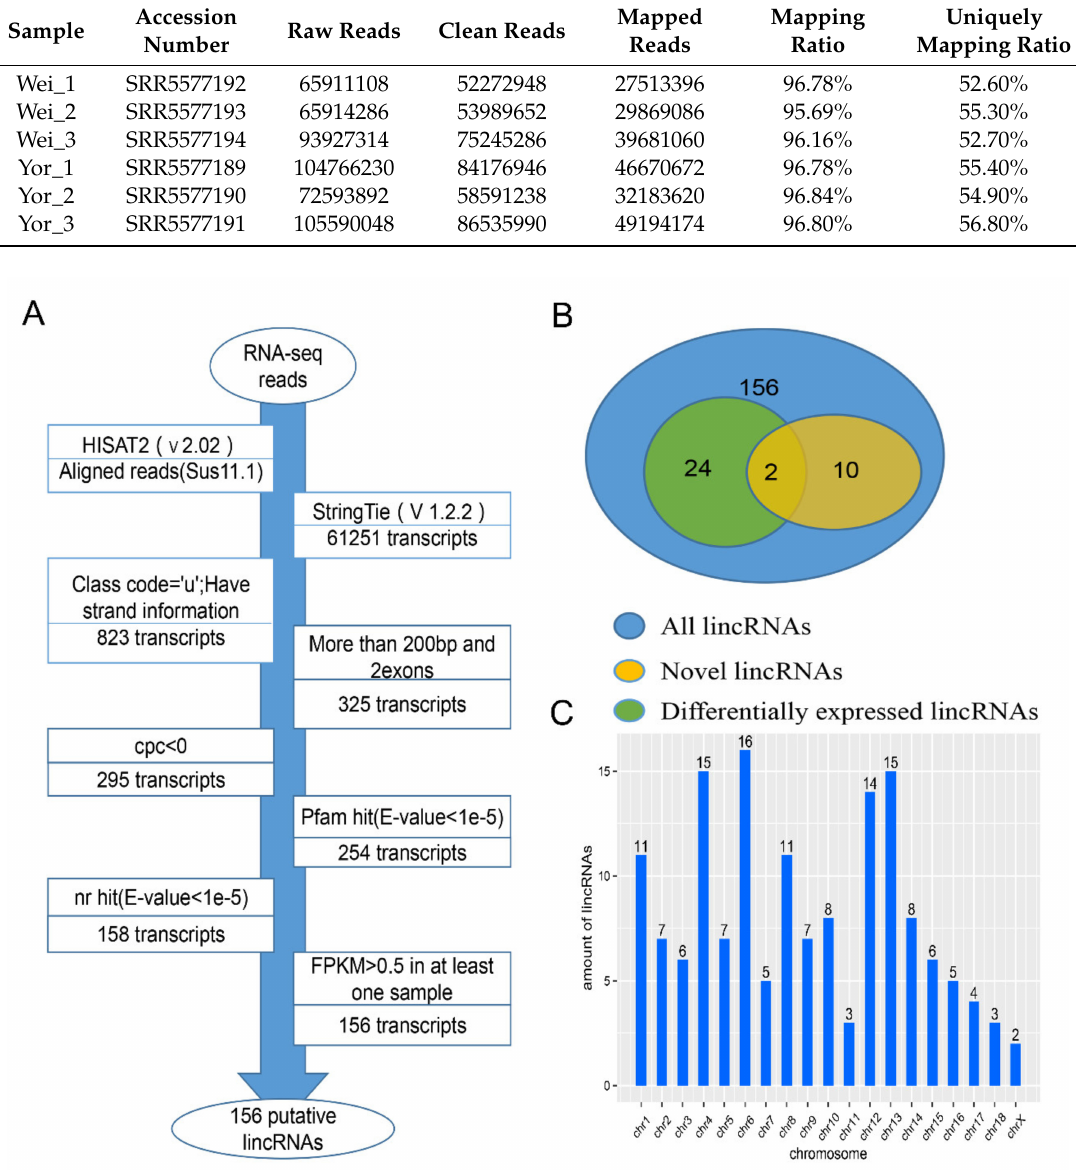
Figure 1. ( A ) Identification pipeline of lincRNAs; ( B ) Venn program of di ff erent kinds of lincRNAs; ( C ) distribution of lincRNA on